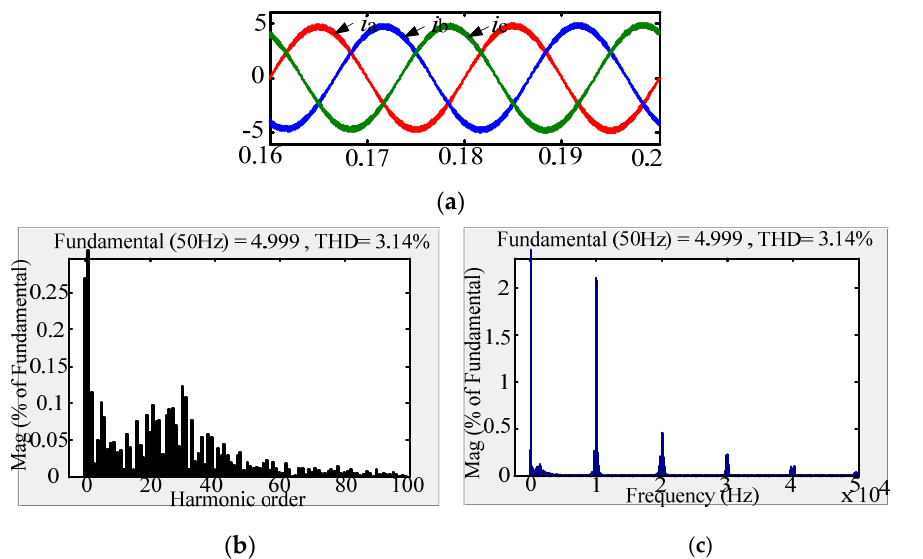
Figure 10. AC-side current waveform of traditional passive damping scheme. ( a ) AC-side current; ( b ) Low-frequency harmonic FFT analysis; ( c ) High-frequency harmonic FFT analysis.